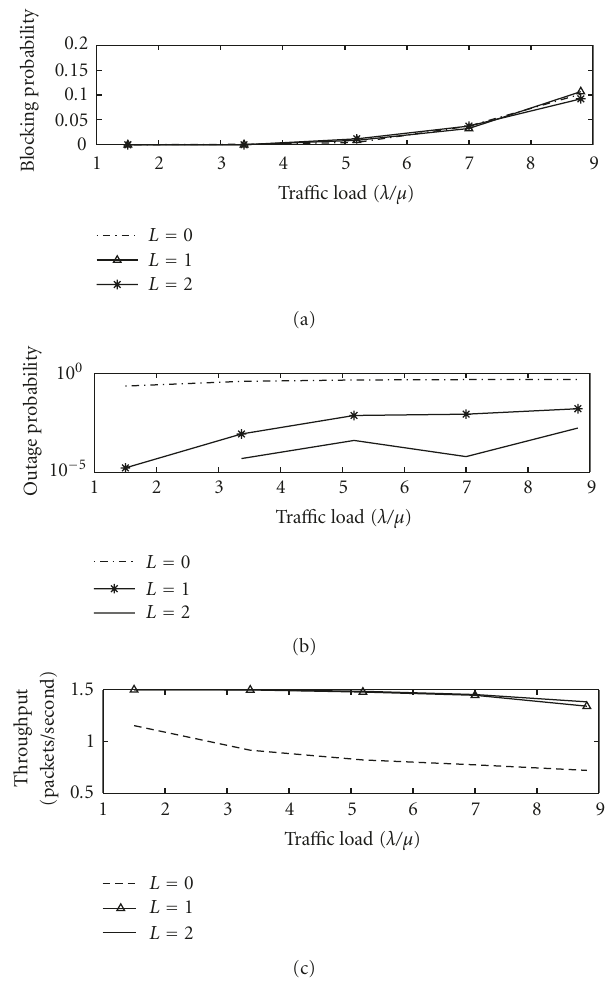
Figure 11: Blocking probability, outage probability, and through- put as a function of overall tra ffi c load in which ρ